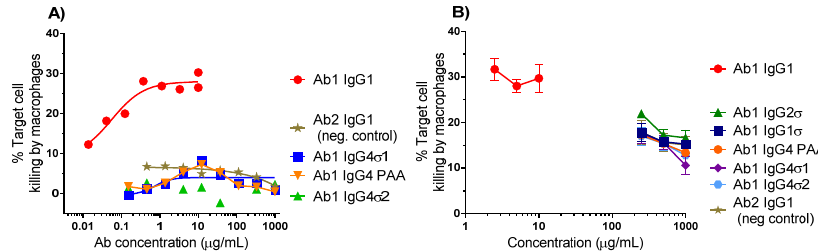
Figure 5. Antibody ‐ Dependent Cellular Phagocytosis (ADCP) (phagocytosis) assays. The extent of phagocytosis was measured using flow cytometry. ( A ) A representative experiment, showing the %Target cell killing by macrophages in a 5 h assay with different concentrations of test antibodies; ( B ) Results using macrophages from a different donor tested in triplicate with a focus on high Ab concentrations (200–1000 μ g/mL). % Target cell killing is the number of dual ‐ labeled cells (target cells engulfed by macrophages) divided by total number of target cells × 100. Error bars represent ± standard error of the mean.